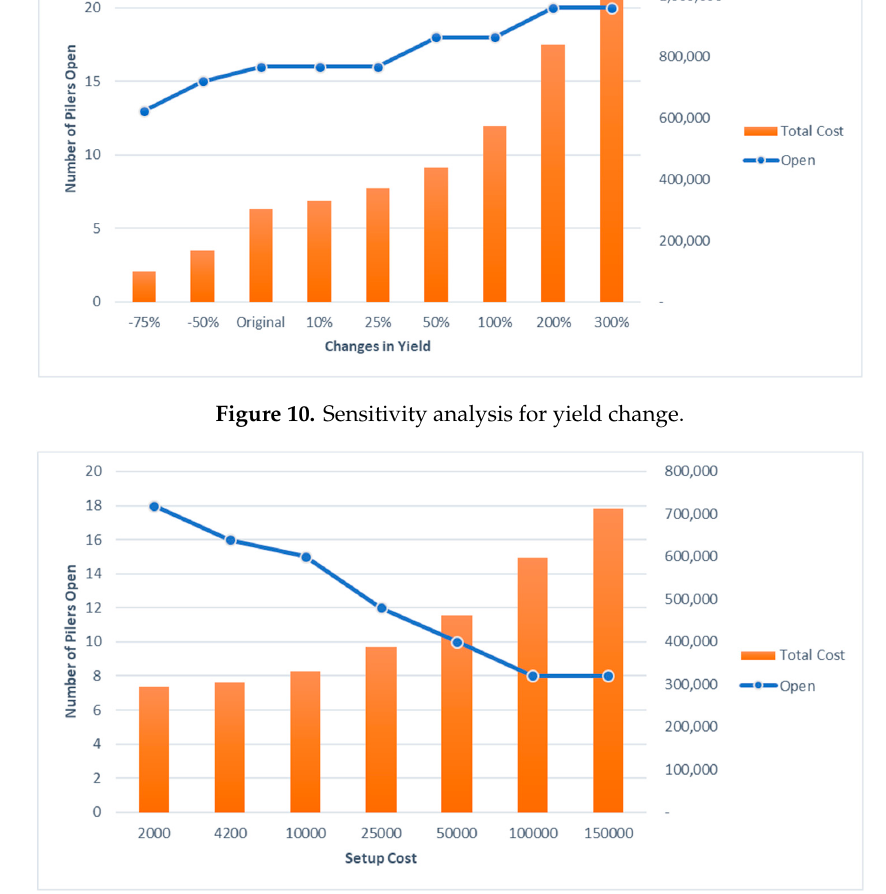
Figure 11. Sensitivity analysis for piler set up cost.